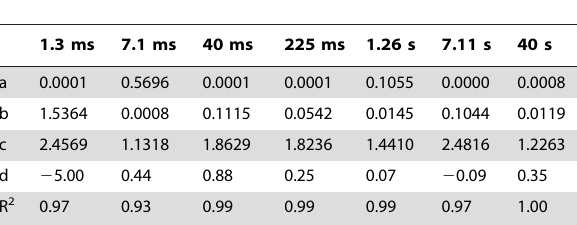
Table 5. Parameters for the k i (L) functions in m3SR. Table 6. Parameters for the k i (L) functions in m4LR.